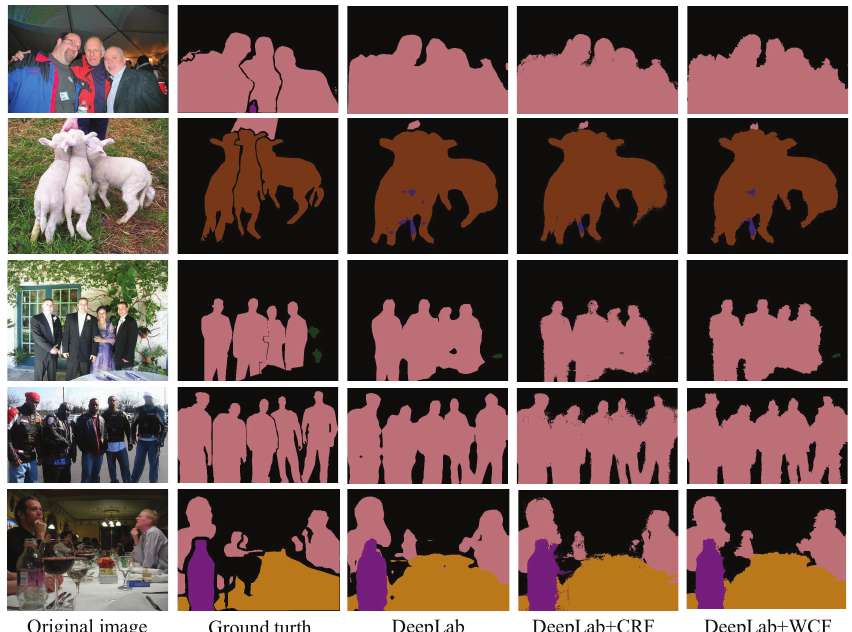
Figure 9. Enhancement of segmentation results of DeepLab for the complex scene with multiple objects of the same type. From the first column to the fifth column are the original images, the ground truth of images, the preliminary segmentation results by DeepLab, enhancement results by DeepLab+CRF and enhancement results by the proposed method